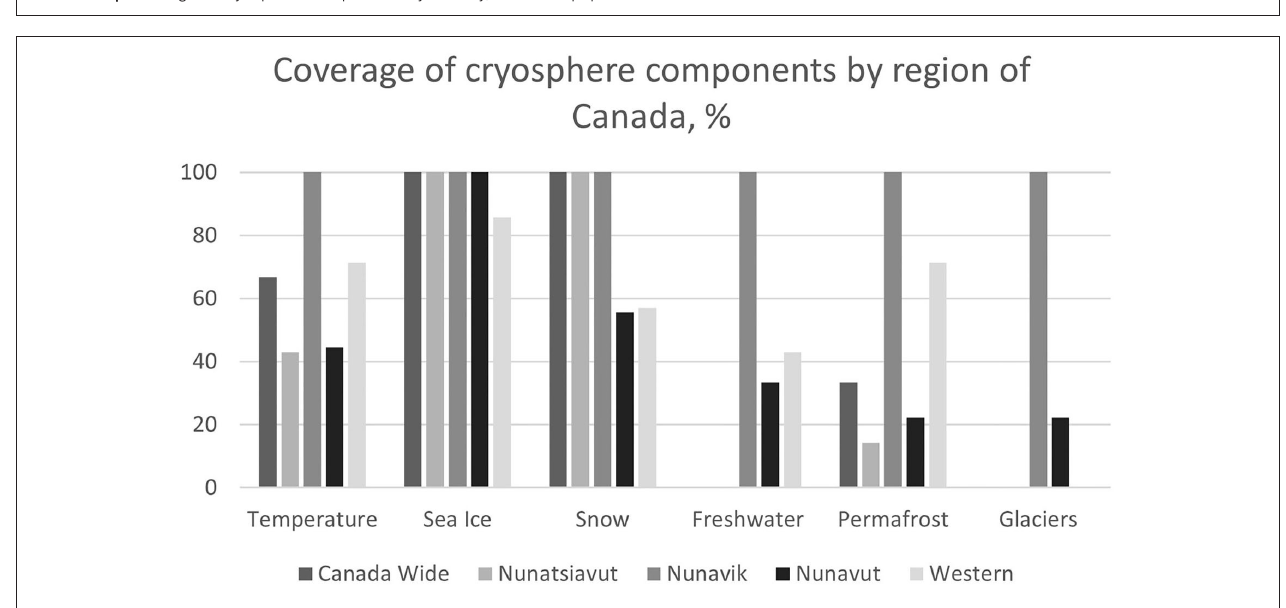
FIGURE 3 | Coverage of cryosphere components by region of Canada, % of total